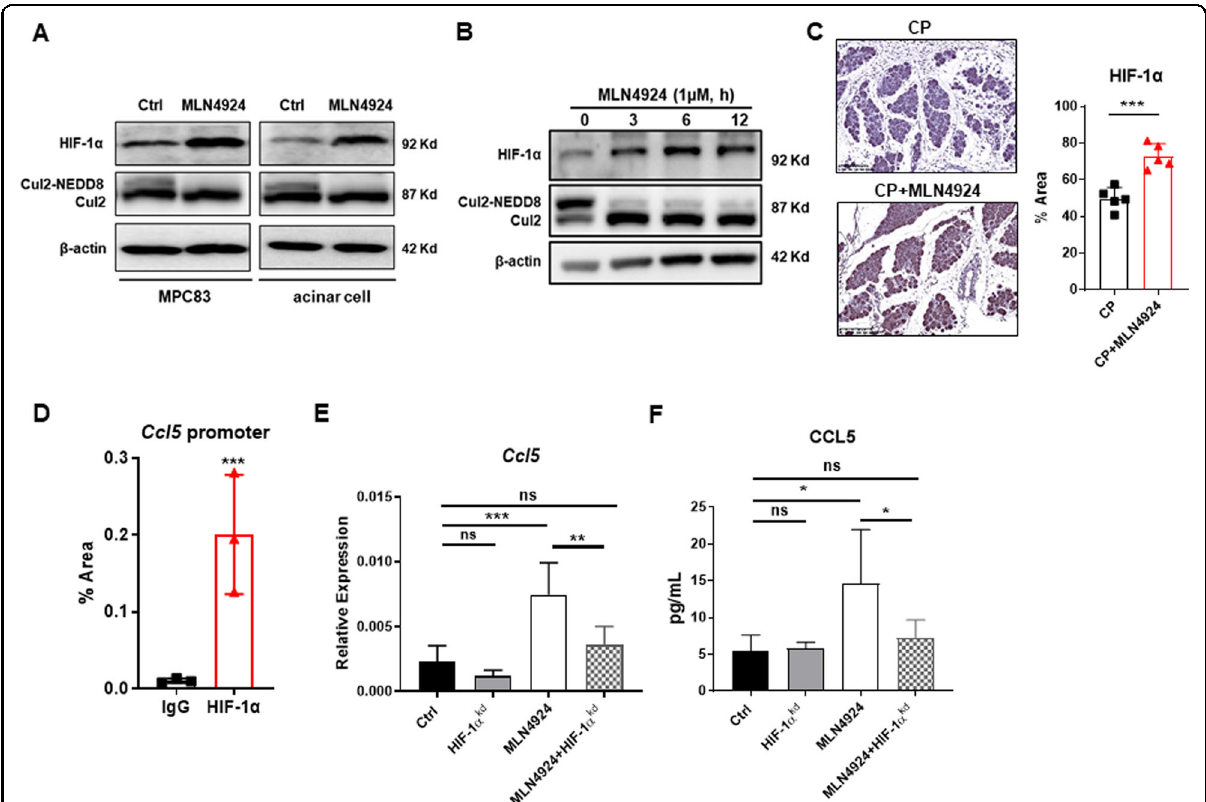
Fig. 5 Neddylation inactivation upregulates CCL5 via a HIF-1 α dependent manner. A WB analysis of HIF-1 α and cullin 2 in MPC-83 cells and primary acinar cells. B WB analysis of HIF-1 α and cullin 2 in pancreatic acinar cells. C Representative IHC images of HIF-1 α , and bar graphs. Scale bar, 200 μ m. D ChIP-qPCR analysis of HIF-1 α binding to the Ccl5 promoter region, IgG was used as the control. E mRNA expression of Ccl5 in si- Hif1a or si- scramble treated acinar cells. F Secretion levels of CCL5 in si- Hif1a or si- scramble treated acinar cells. A , B , D n = 3. C , E , F n = 5. Data are representative of three independent experiments. *p < 0.05, ** p < 0.01, *** p < 0.001, ns no signi fi cant. Cul-2, cullin2, pos positive control, neg negative